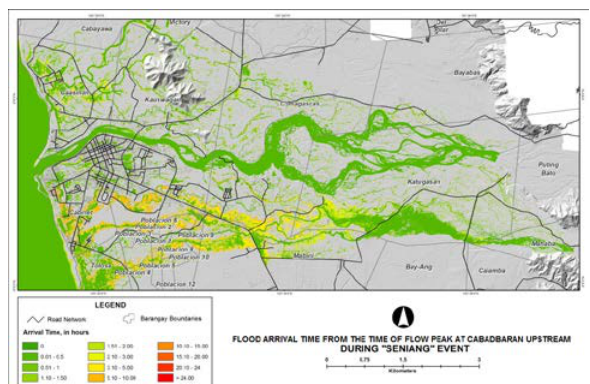
Figure 9. Map showing flood arrival times from the start of the simulation period of the Seniang event.